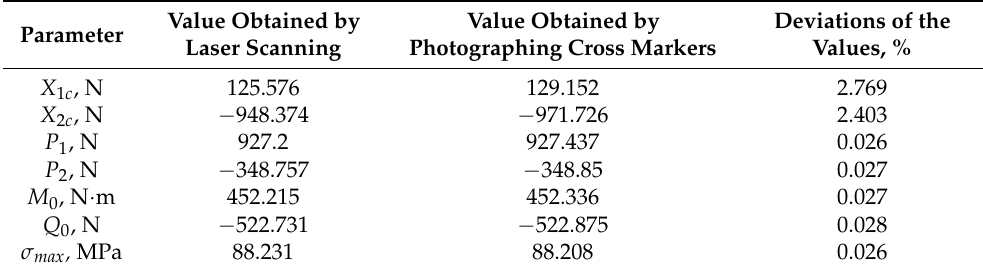
Table 2. The results of the calculation of the reaction forces arising in the hydraulic cylinders and the forces required to center the end of the pipeline used during the laboratory research.